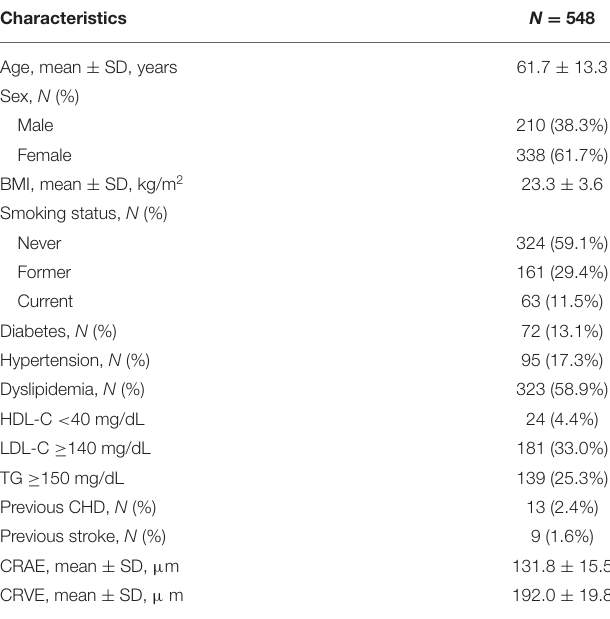
TABLE 2 | Relationship between participants’ background data and retinal vascular caliber (CRAE and CRVE).